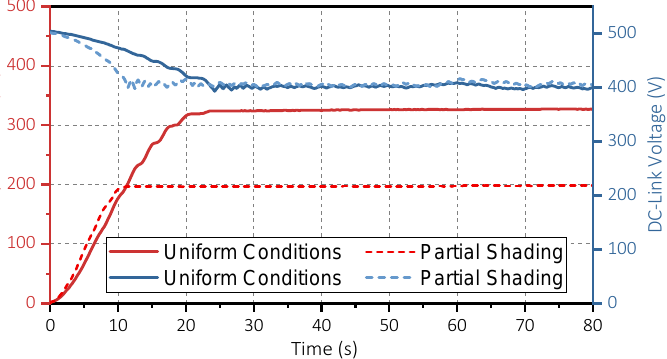
Figure 13. Response of the new VMPV architecture during real-time MPPT, under uniform and PS conditions. Output power (in red) and DC-bus voltage (in blue) variation with time.